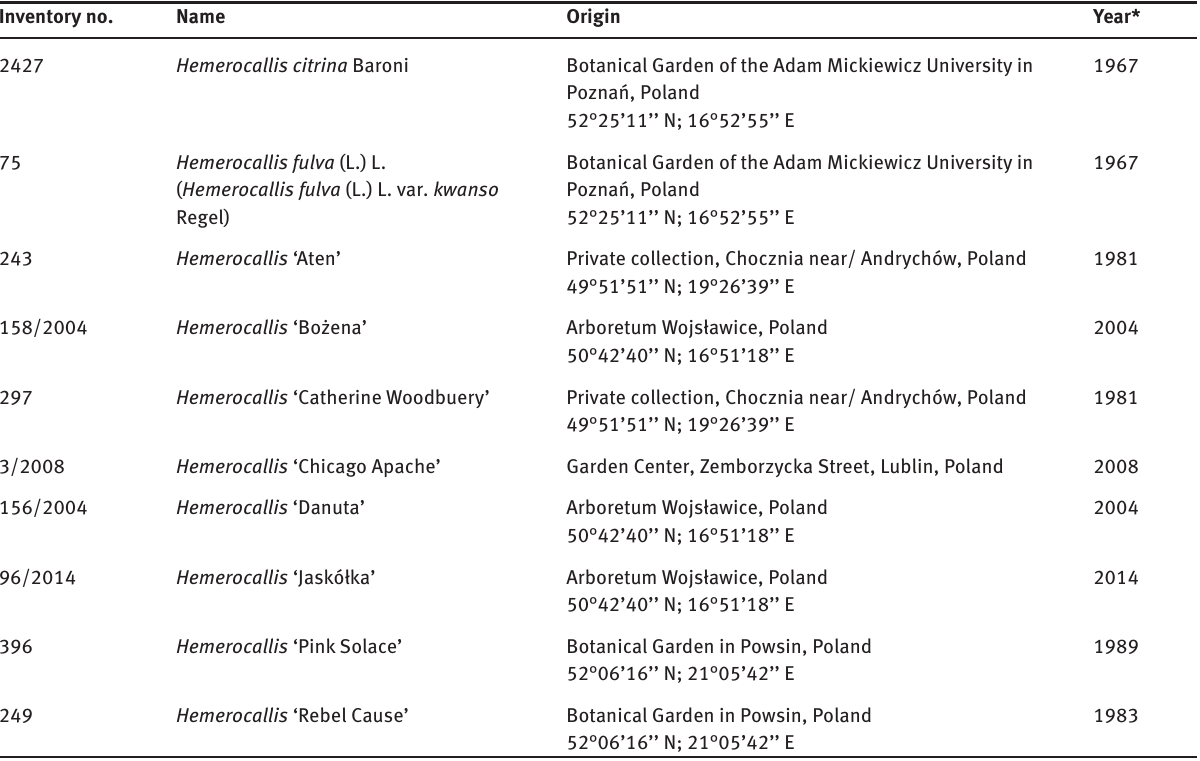
Table 1 : Hemerocallis cultivars used in the experiment for EOs determination. *Year of introduction to cultivation in Botanical Garden in Lublin (Poland). Inventory